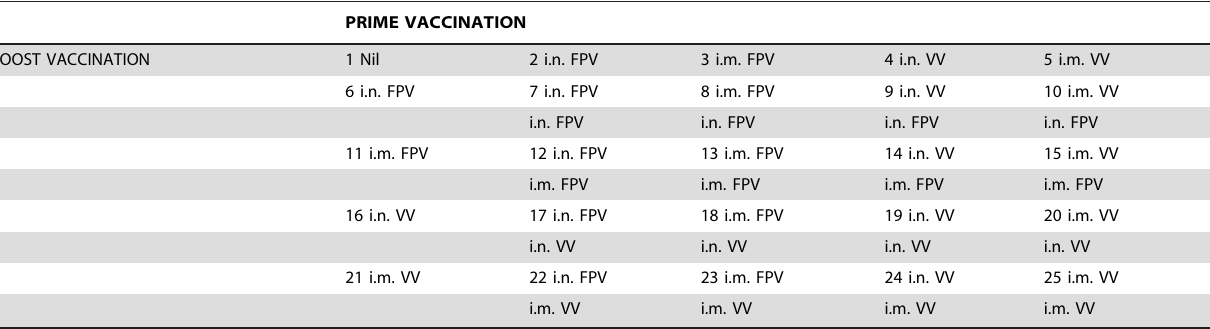
Table 1. HIV-1 pox virus vaccination regimes used in this